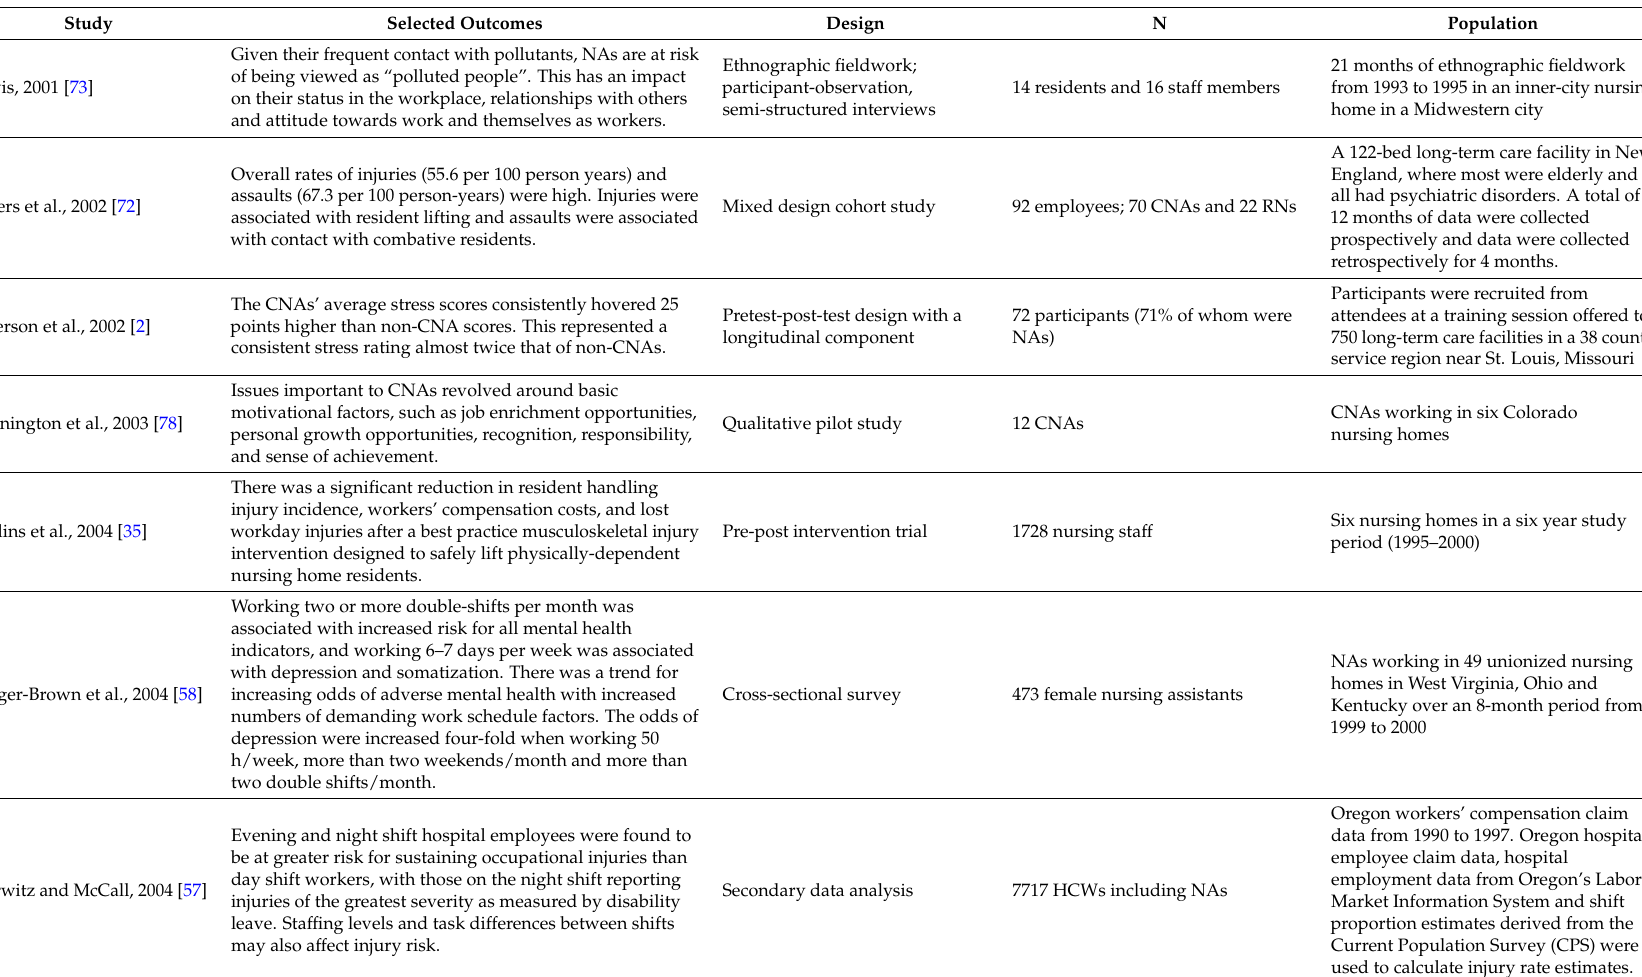
Table 5. Summary of literature reviewed for occupational health and safety hazards to nursing assistants—psychosocial